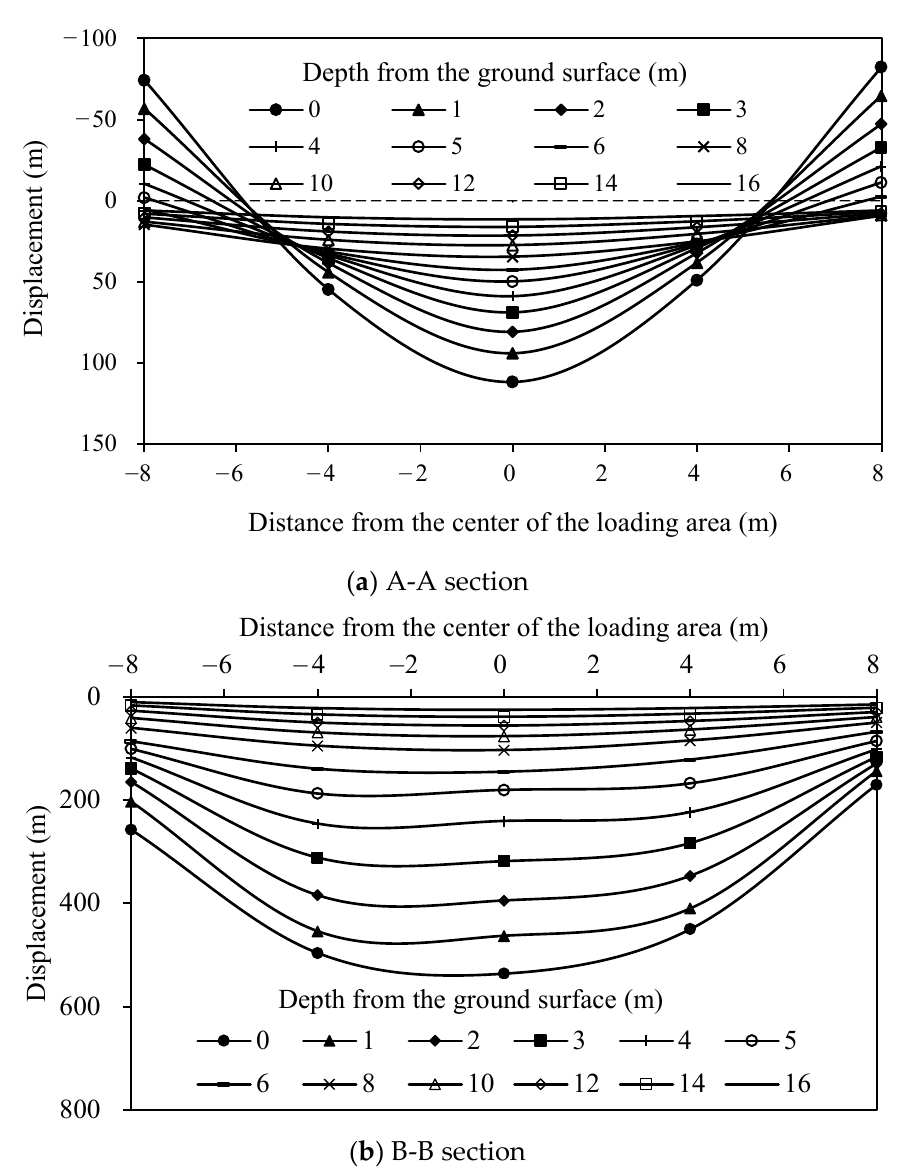
Figure 7. The vertical displacement curves of the foundation soil at different depths at: ( a ) A-A section; ( b ) B-B section.